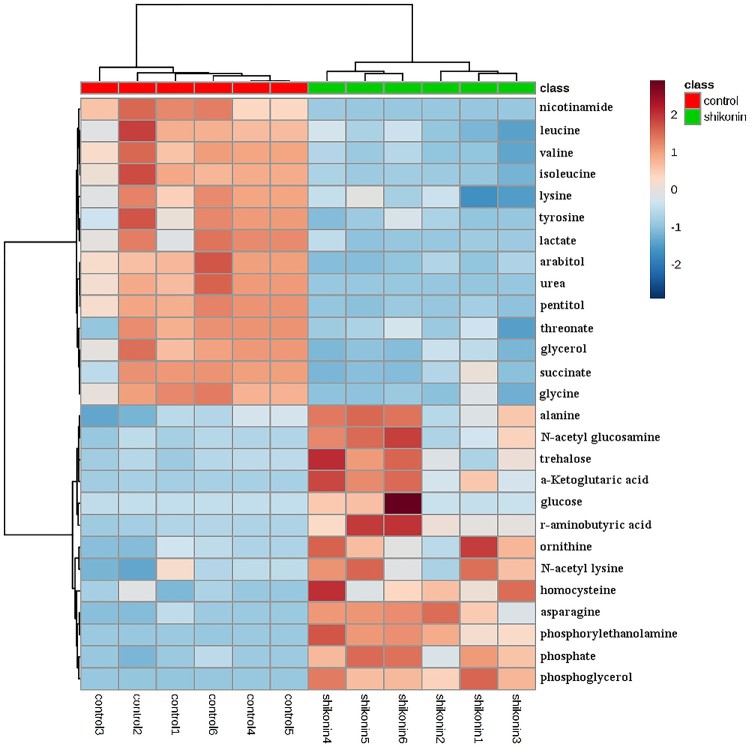
Colours in metabolite arrays represent x-fold change in the metabolite concentration in SK-treated and control groups. Brick-red indicates increased concentration levels of metabolites; blue indicates decreased concentration levels of metabolites. The two groups can be well recognized by cluster analysis of 27 potential biomarkers.